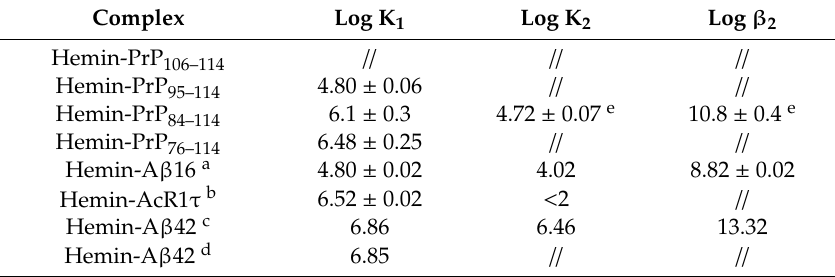
Table 1. Equilibrium constants for hemin binding to neuronal peptides in phosphate bu ff er solution at pH